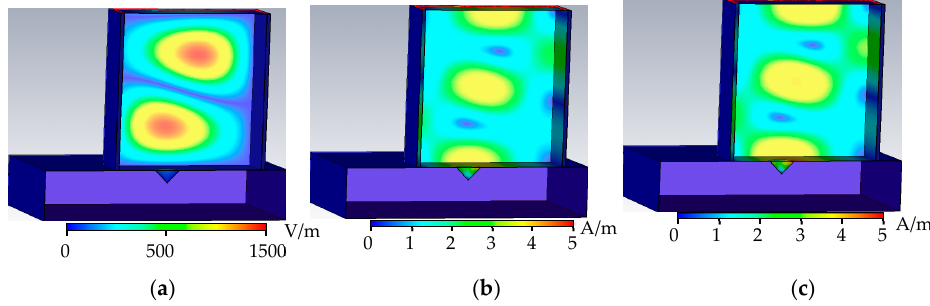
Figure 7. Cone defect field distribution. ( a ) Cone defect electric field distribution. ( b ) Cone defect magnetic field distribution. ( c ) Cone defect wall current distribution.